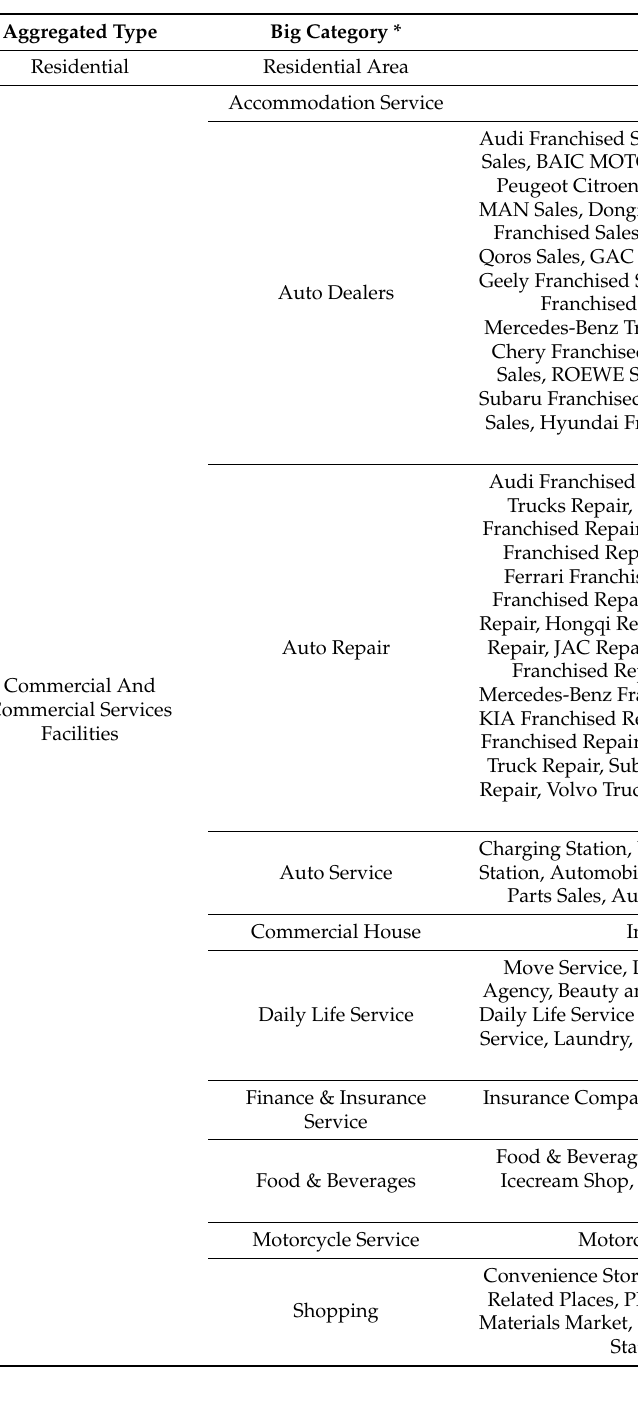
Table 1. Types of original and aggregated